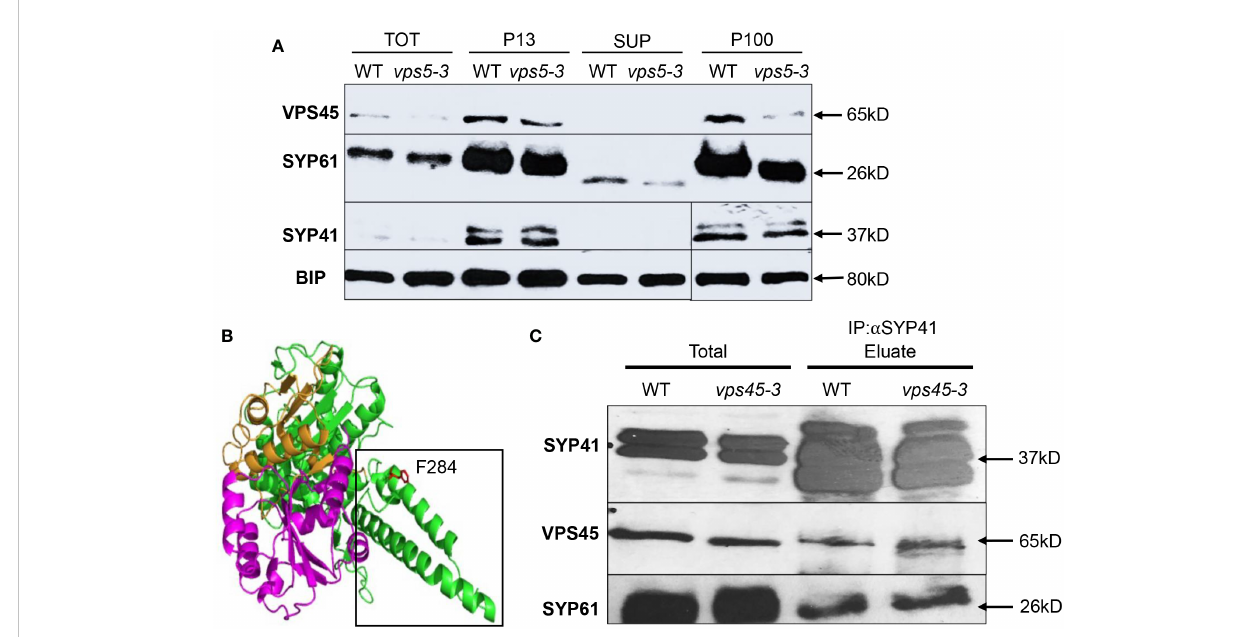
FIGURE 4 VPS45-3 maintains stability and interaction with SYP41 SNARE complex. (A) VPS45-3 maintains proper subcellular distribution and stability of SYP41 and SYP61. Total protein samples from 7-day-old wild-type and vps45-3 plants were subjected to subcellular fractionation by centrifugation to obtain a total fraction (TOT) after centrifugation at 5,000 g , low speed pellet (P13) after centrifugation at 13,000 g , soluble fraction (SUP) and high- speed pellet (P100) after centrifugation at 100,000 g . Aliquots of fractions were analyzed by SDS-PAGE followed by immunoblotting with the indicated antibodies. (B) Homology model of the predicted Arabidopsis VPS45-3 protein sequence modeled onto the crystal structure of c6MX1 from Chaetomium thermophilum (RCSB PDB). The mutated residue is shown in red and labeled and is in the 3a domain as shown by the black outline. (C) VPS45-3, SYP41, and SYP61 coimmunoprecipitate with SYP41 antibodies. Detergent solubilized membrane preparations from Arabidopsis leaves were subjected to immuno-isolation using SYP41 antibodies. Aliquots of total extracts and the eluate from the antibody column were analyzed by SDS-PAGE and immunoblotting with the indicated